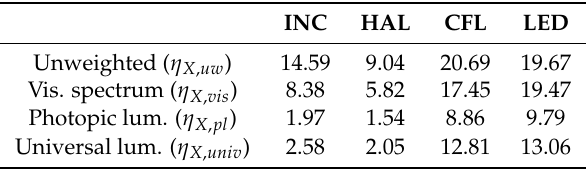
Table 6. Valuable exergetic efficiencies ( η X , L , v , in %) for each lamp and weighting function ( f λ ), given by the incandescent (INC) and halogen (HAL) lamps, because the SPD data do not go beyond 899 nm, despite INC and HAL emission beyond 900